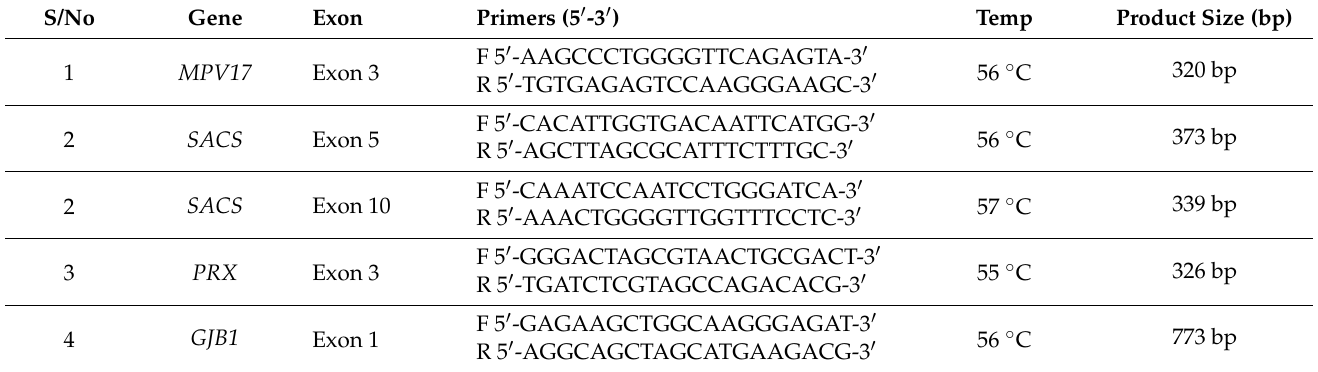
Table 2. Primer list with gene name, exon No., annealing temperature, and product